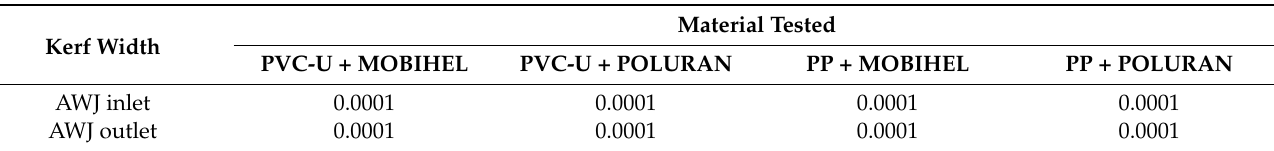
Table 2. Statistical evaluation of the width of the cutting gap of polymer materials with surface treatment according to ANOVA F-test with the given parameter p at the significance level α = 0.05.